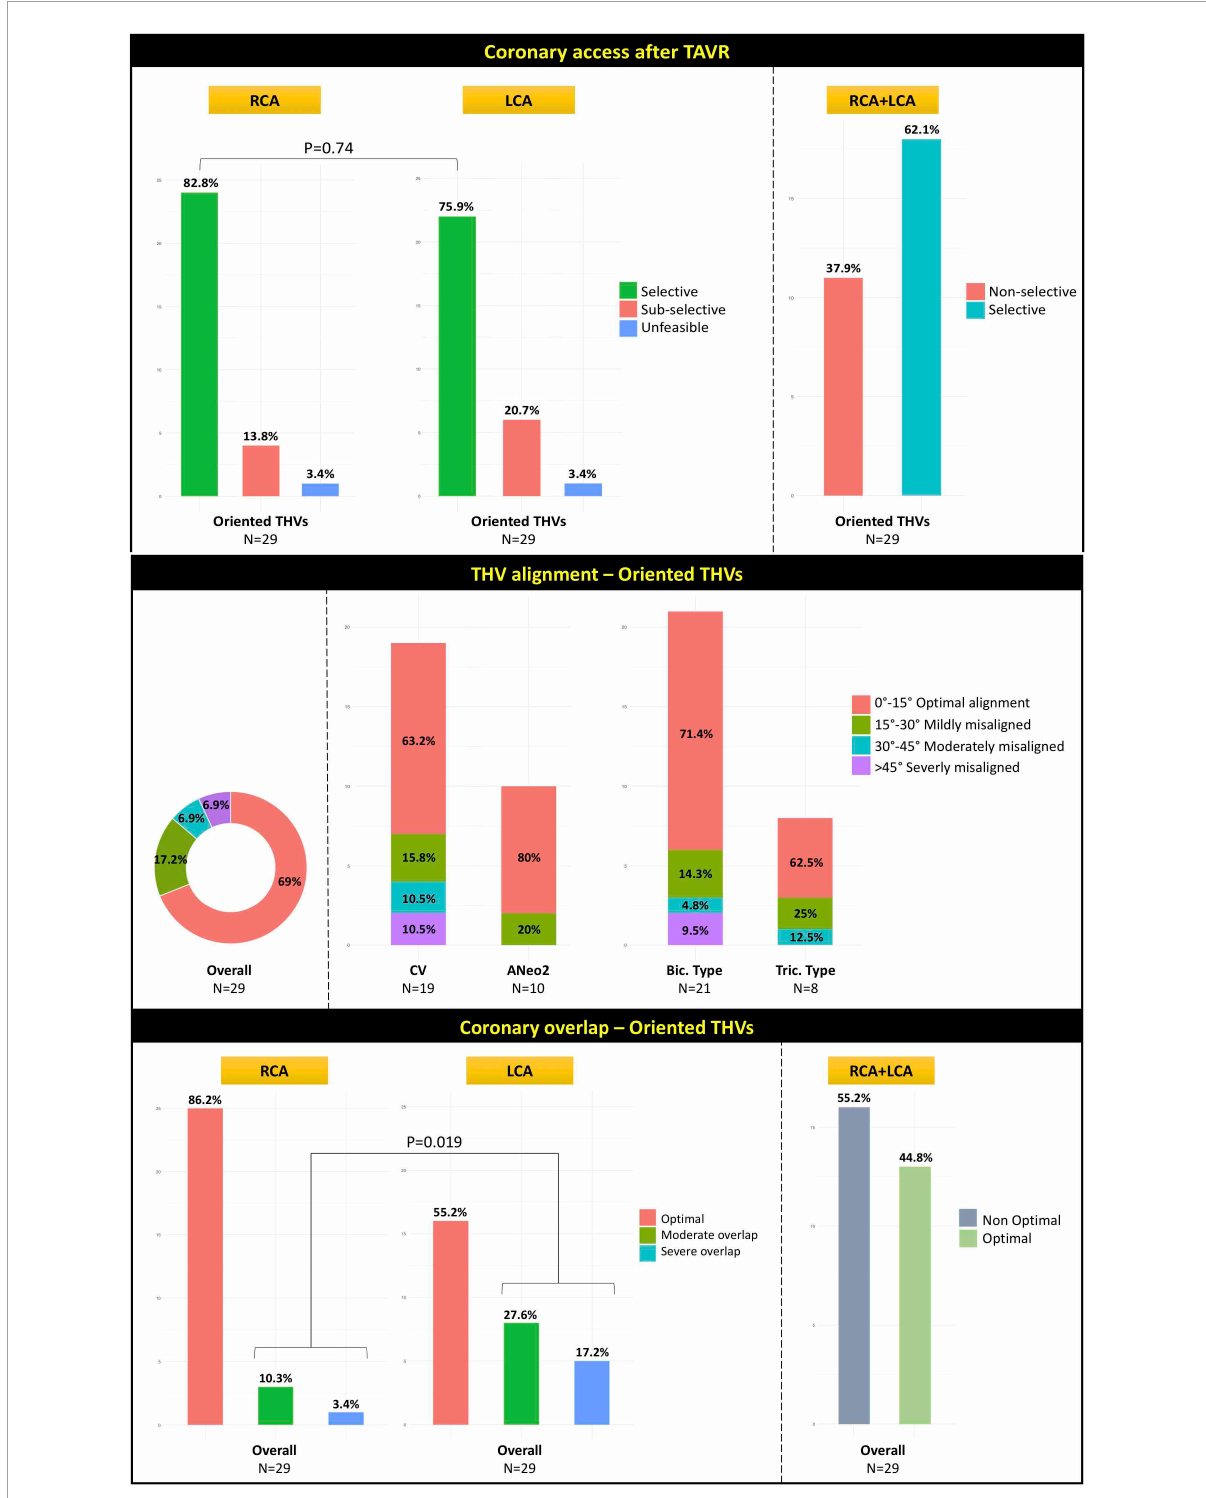
FIGURE4 Illustration of the rates of CA after TAVR for RCA, LCA, and combined RCA/LCA (top panel) , rates of the degree of THV alignment (middle panel) , and neo-commissural/coronary overlap (bottom panel) in the 29 patients with fluoroscopically oriented THV. CA, coronary access; TAVR, transcatheter aortic valve replacement; RCA, right coronary artery; LCA, left coronary artery; THV, transcatheter heart valve; CV, CoreValve; ANeo2, Acurate Neo2; Bic., bicommissural; Tric.,